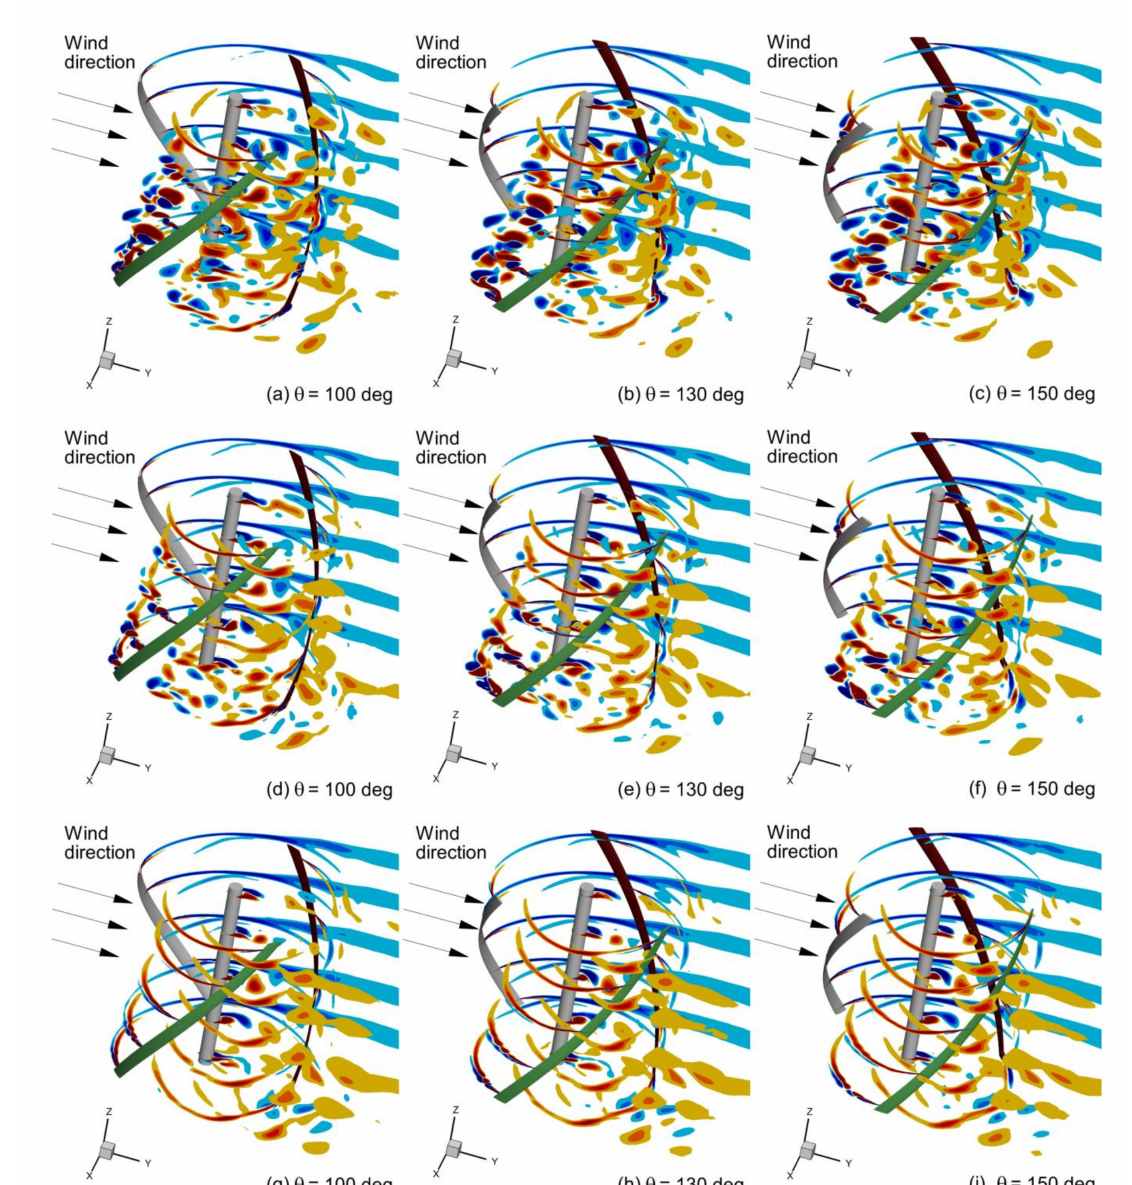
Figure 21. Z-vorticity magnitude of 90 ◦ helical-bladed VAWT at 100 ◦ , 130 ◦ , and 150 ◦ of azimuth angles of rotation of a turbine operating at ( a – c ) TSR = 2.7, ( d – f ) TSR = 3.1, and ( g – i ) TSR =